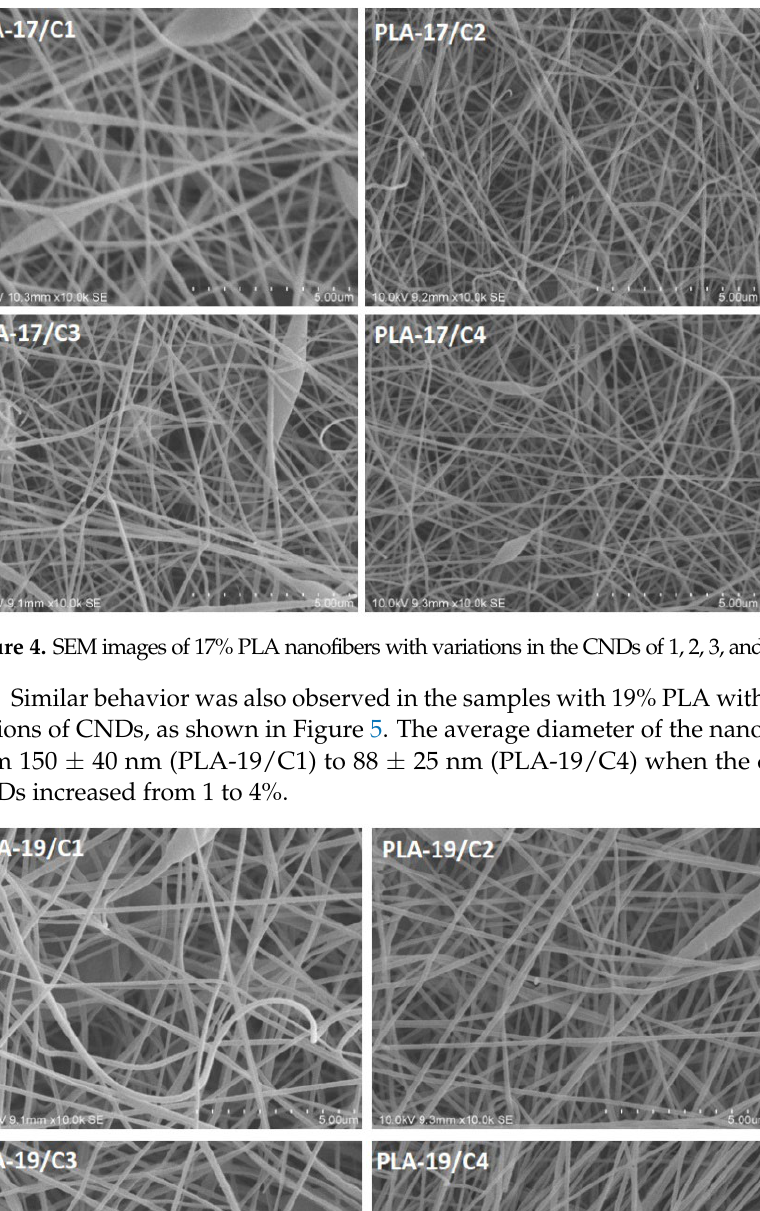
Figure 3. SEM images of pure PLA nanofibers with concentrations of 12, 15, 17, and 19% (scale — 20 µm).